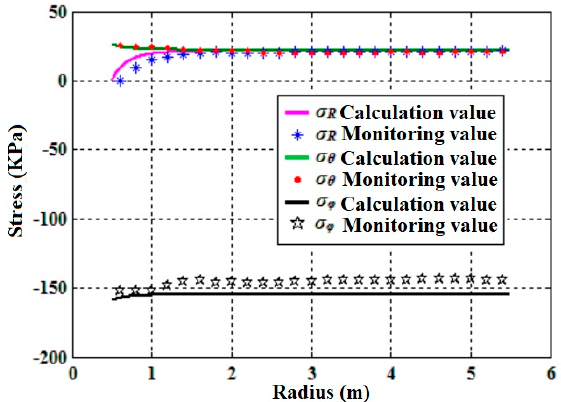
Figure 12. A value comparison.